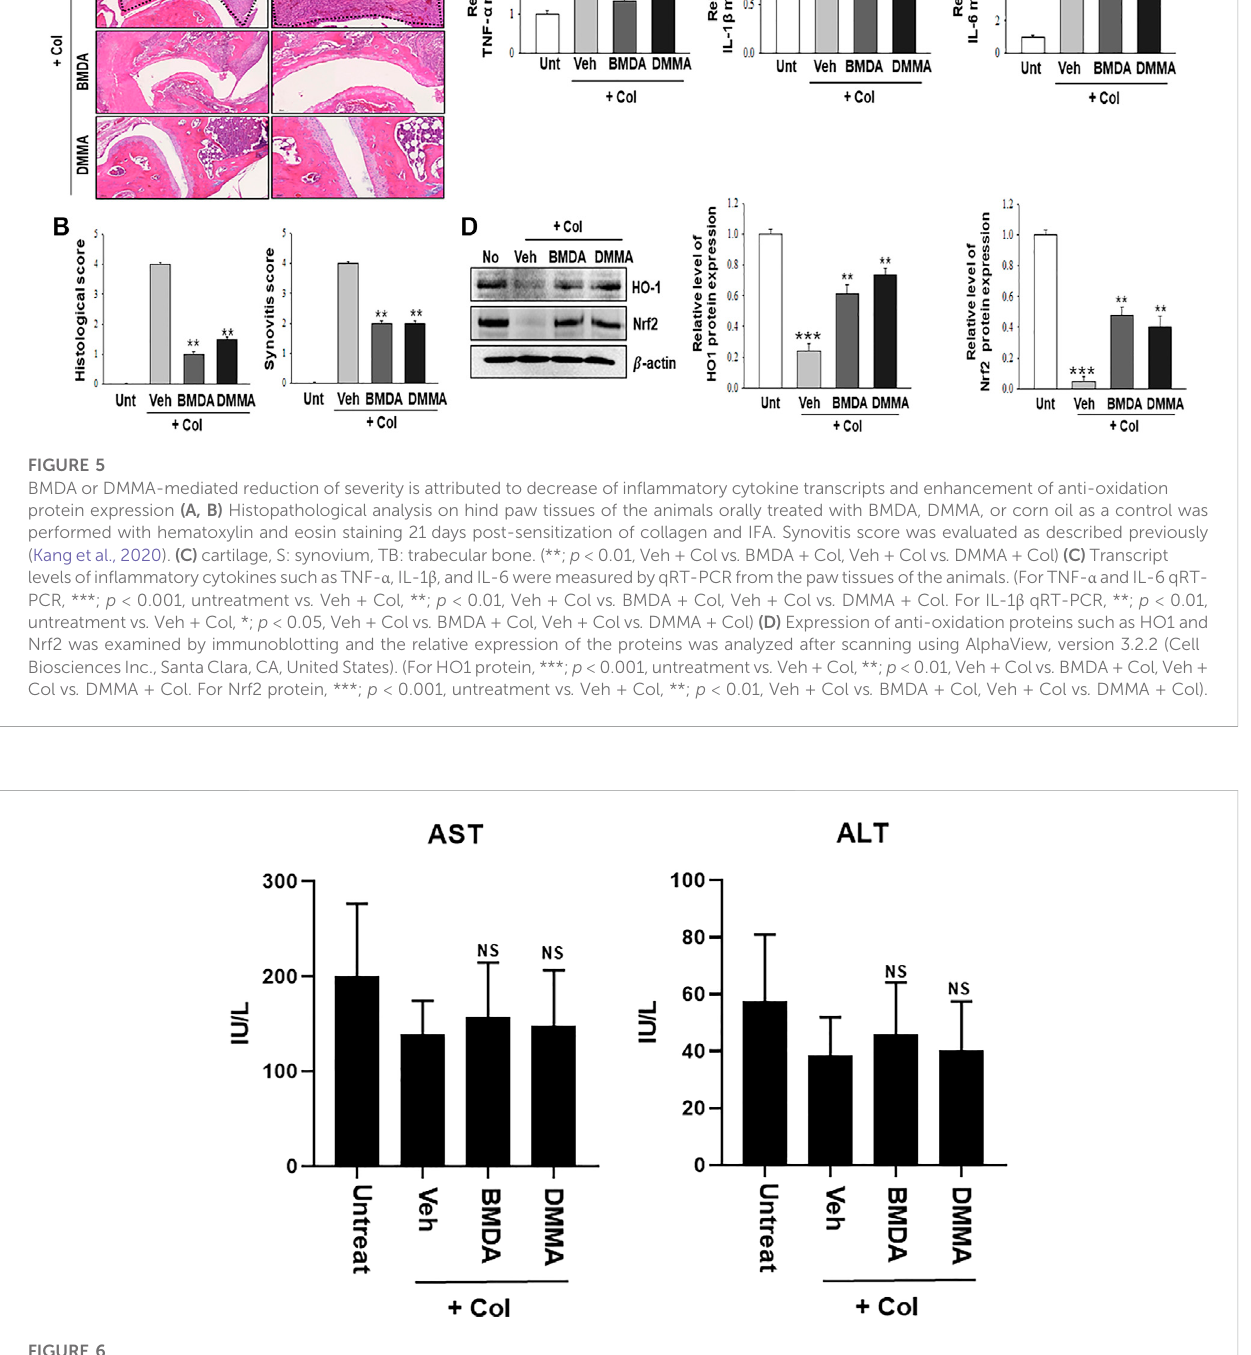
Oral treatment with BMDA or DMMA does not affect liver toxicity in the RA-carrying mice. AST and ALT levels were measured in the sera of RA- carryingmicethatwereorallytreatedwithBMDA,DMMA,orcornoil21 dayspost-sensitizationofcollagenandIFA.NSindicatesnotsigni fi cant(ns;Veh+ Col vs. BMDA + Col, Veh + Col vs. DMMA +